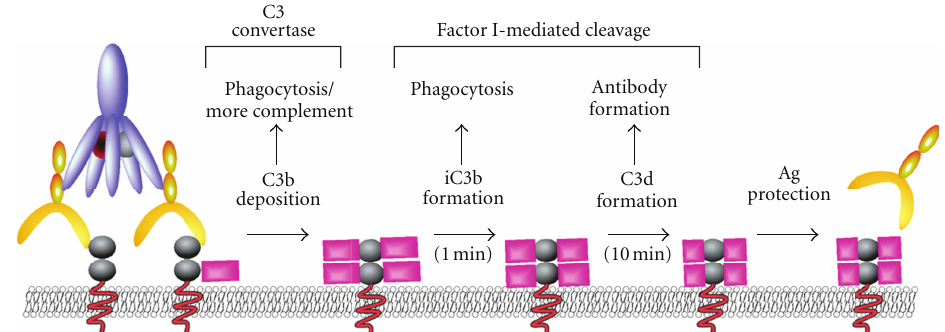
Figure 2: C3 degradation following complement activation. Conversion of C3 to C3b by C3 convertase complex results in rapid deposition of highly reactive C3b on the target surface. Degradation by inhibitory factor I, in concert with other regulatory molecules, results in conversion of C3b to iC3b. Although iC3b retains the capacity of C3b to engage complement receptors as an opsonin, it no longer participates in the production of additional complement. Additional cleavage of iC3b by factor I results in the formation of C3d, which no longer fixes complement or serves as an opsonin, although it may engage B cells and facilitate antibody formation. Decoration of antigen with C3d may result in protection of the antigen from additional antibody binding and subsequent e ff ector